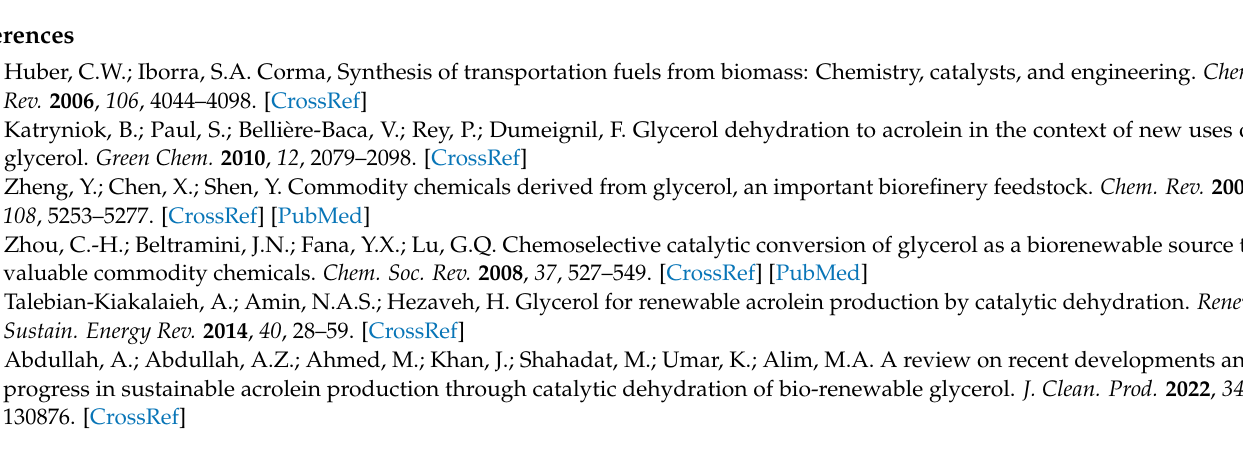
Figure S5. NH 3 -TPD of 20 %P-ZSM-5_280; Figure S6. NH 3 -TPD of CsPW; and Figure S7. NH 3 -TPD of